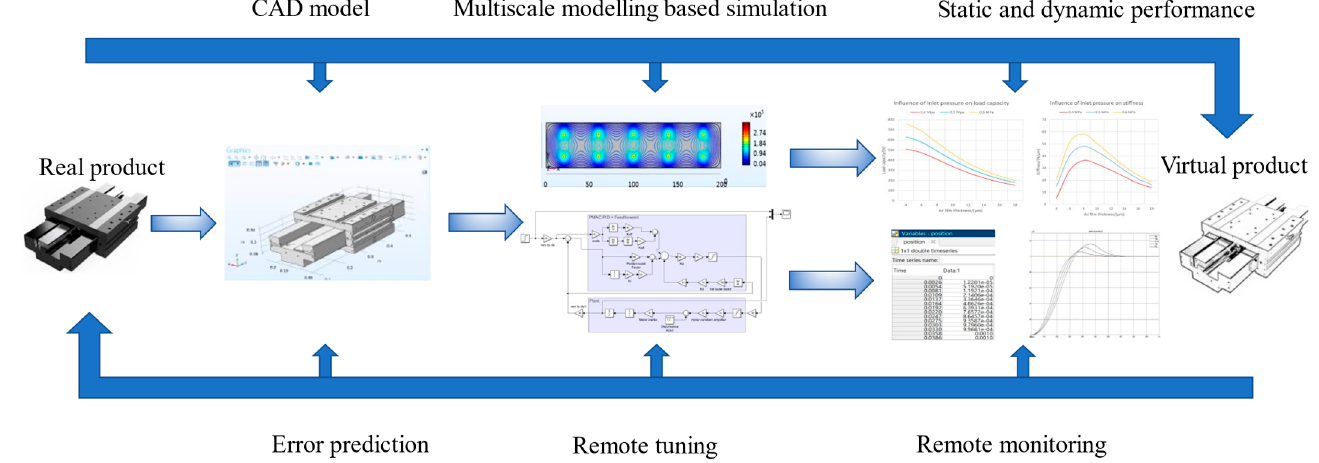
Figure 16. Schematic of the aerostatic bearing slideway digital